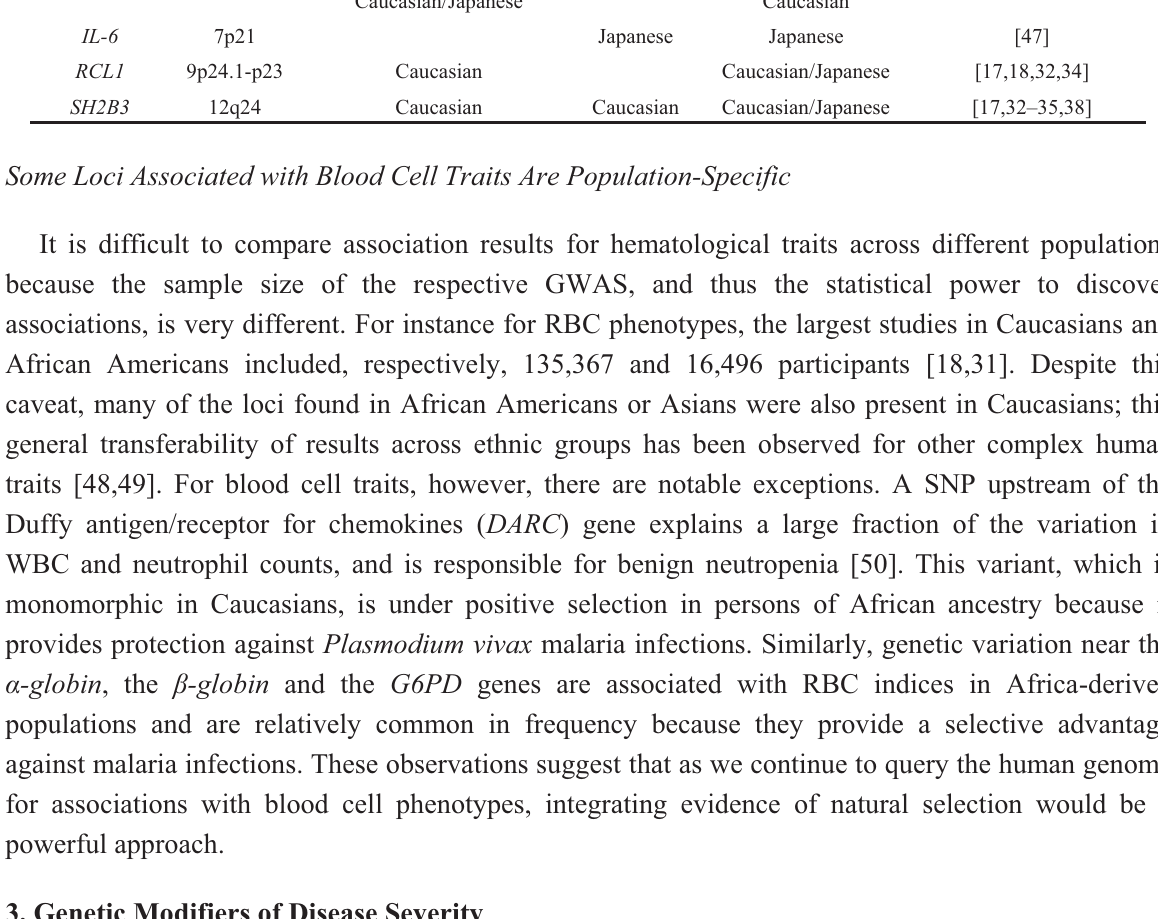
Table 2. Loci identified by GWAS that carry SNPs associated with at least two of the three main blood cell types. For each association, we report the ethnic group in which the genetic associations were found. We also listed only one gene per locus, although for many loci, the causal gene is unknown. RBC: red blood cell; WBC: white blood cell. Locus Location RBC WBC Platelet TMCC2 1q32.1 Caucasian Caucasian ARHGEF3 3p14.3 African American LRRC16A 6p22.2 HBS1L-MYB